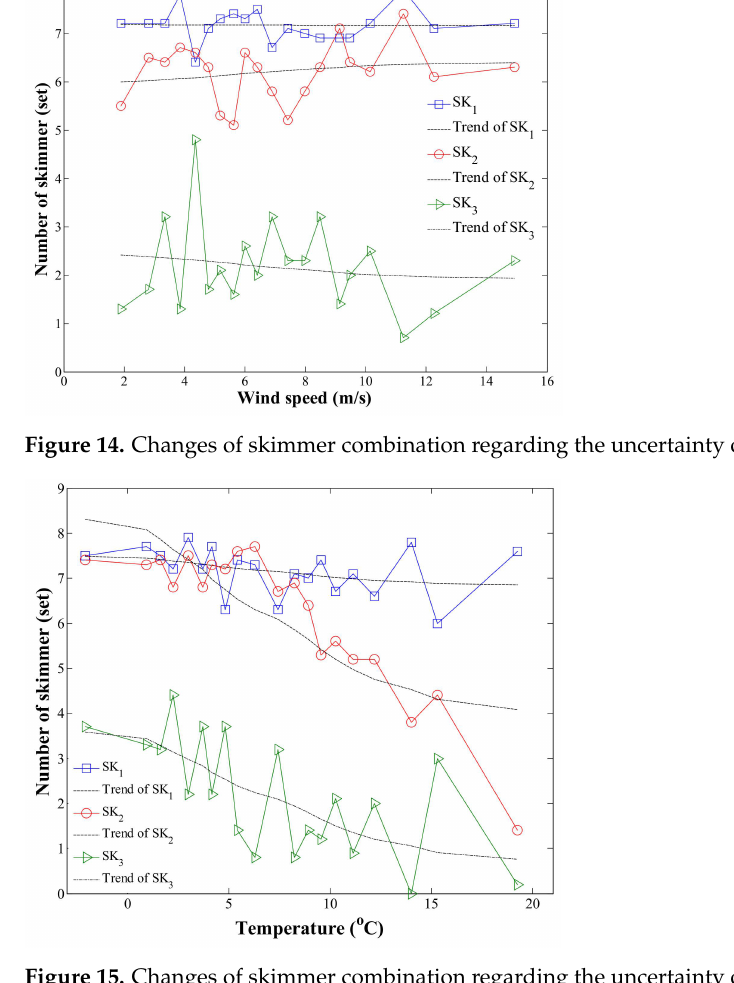
Figure 15. Changes of skimmer combination regarding the uncertainty of seawater